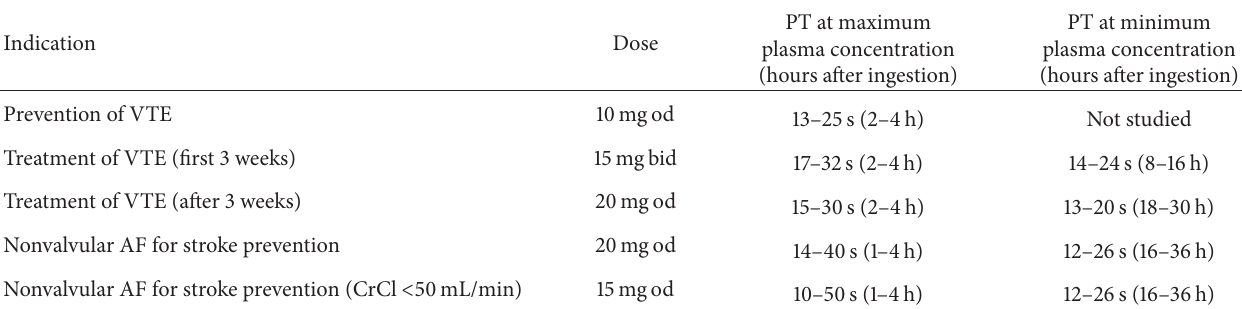
Table 1: Change of prothrombin time in seconds (5–95% percentile) using various rivaroxaban doses and the STA Neoplastine CI Plus Assay